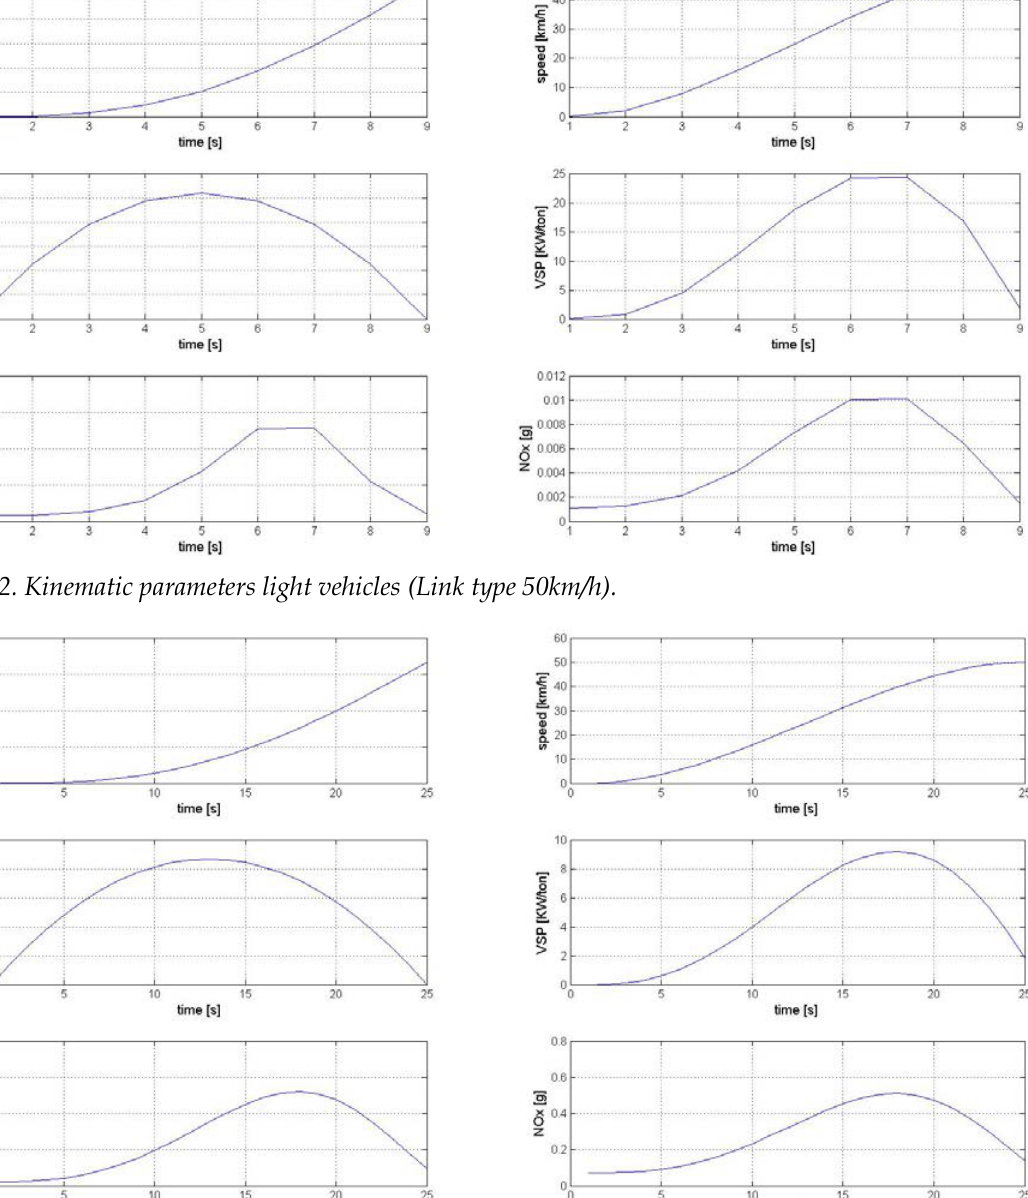
Figure 3. Kinematic parameters heavy vehicles (Link type